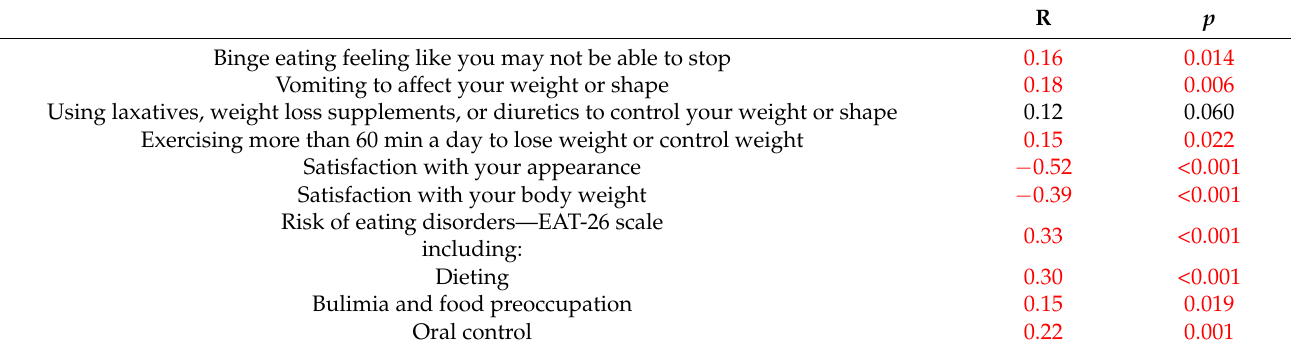
Table 3. The impact of self-esteem on the SES scale on the risk of eating